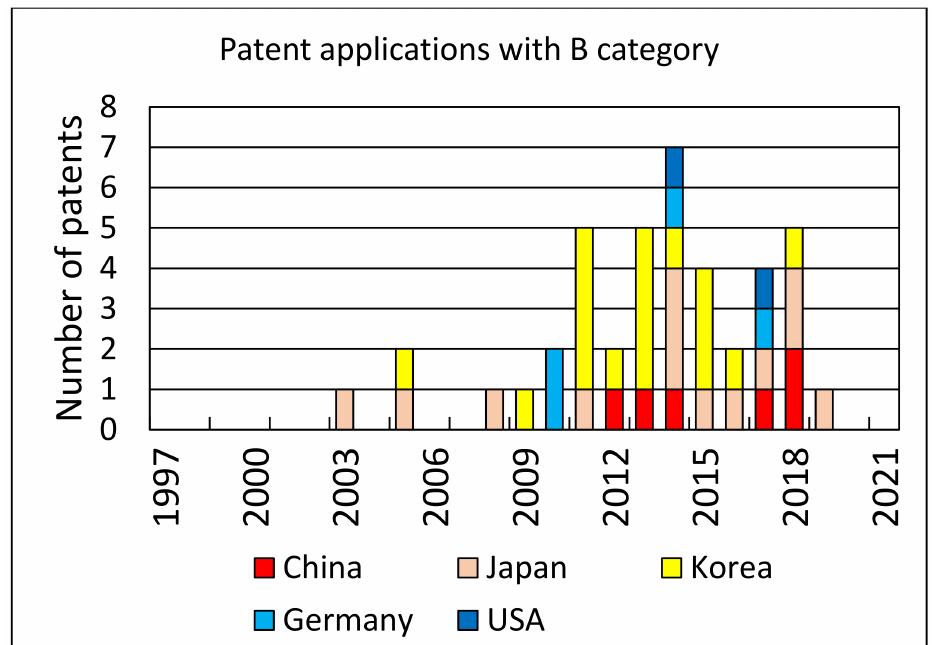
Figure 7. Distribution of the number of patents by country (the B step of a patent application process meaning at least publication and preliminary approval): Korea—17, Japan—13, China—6, Germany—4 and